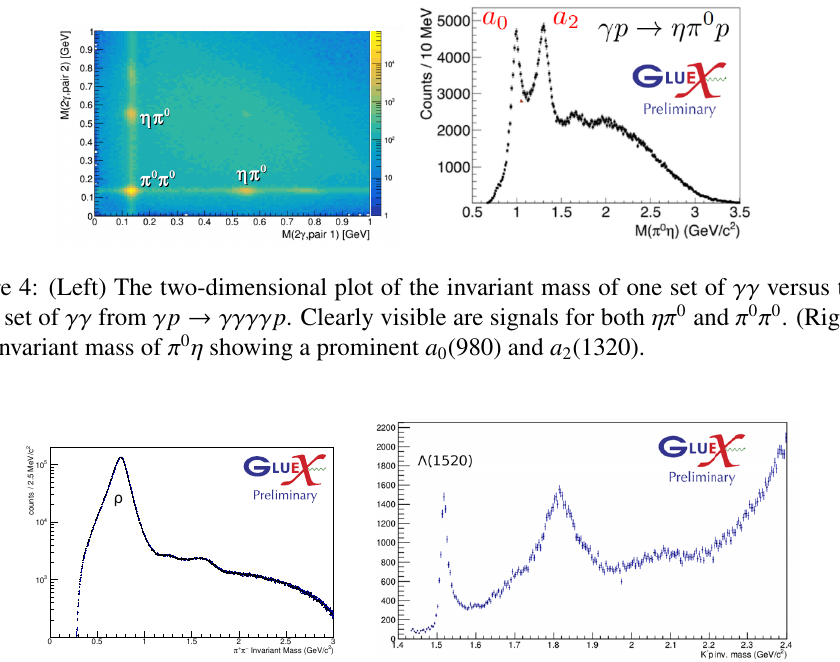
Figure 5: (Left) The invariant mass of π + π − with about 100 times the statistics of the earlier measurement by SLAC. (Right) The invariant mass of K − p showing a multitude of features beyond Λ (1520)